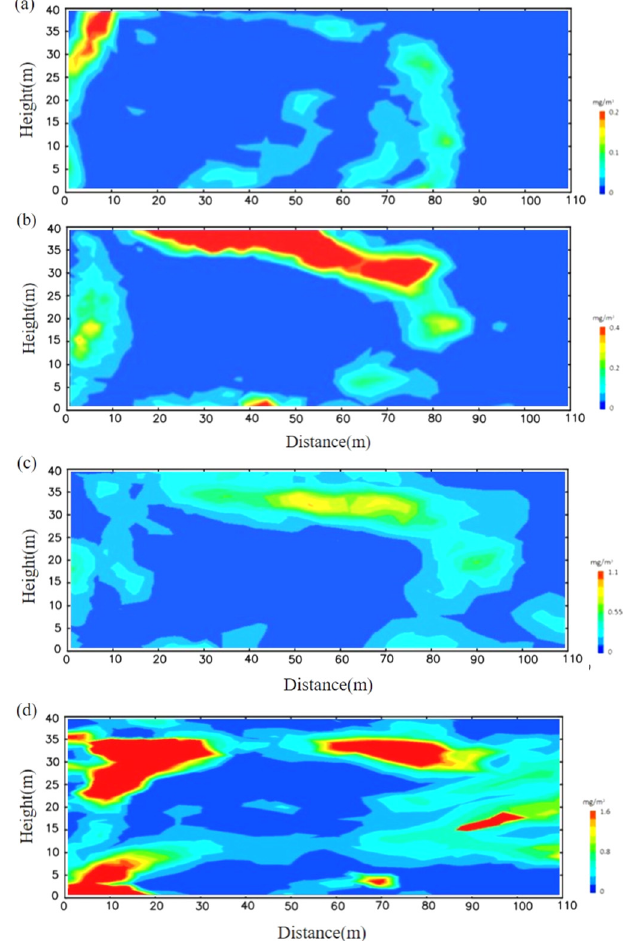
Figure 11. PM concentration profiles at vertical direction at 40 m height by CFD technology: ( a ) PM 1 ; ( b ) PM 2.5 ; ( c ) PM 10 ; and ( d ) TSP (outside).